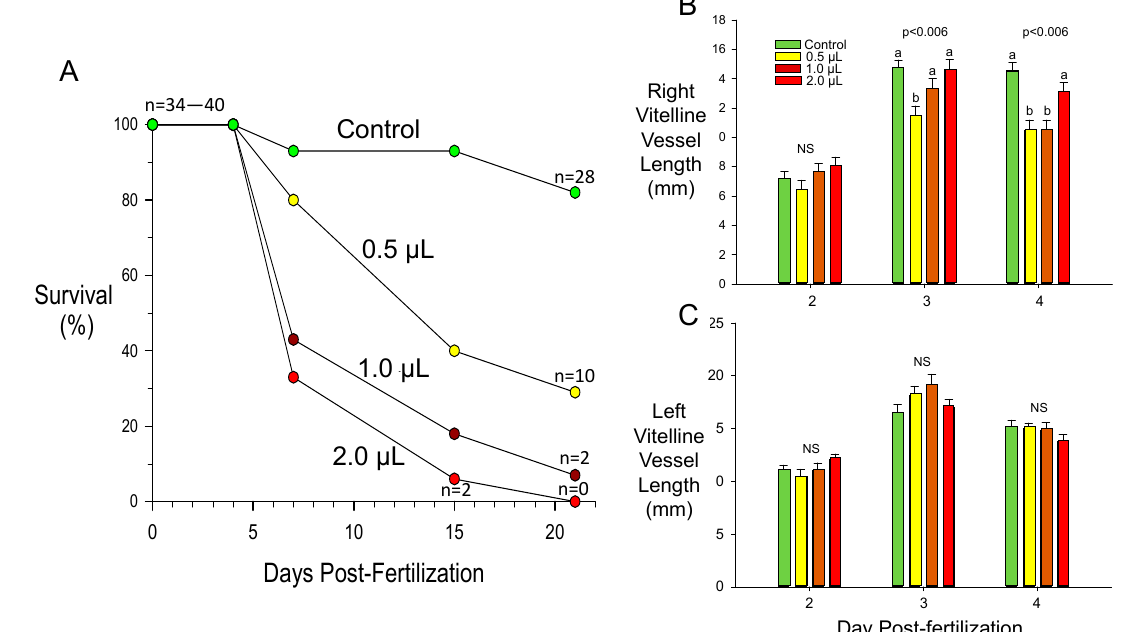
Figure 5. E ff ects of crude oil on survival and CAM vascular growth in chicken embryos grown in ovo. Doses of crude oil of 0, 0.5, 1, or 2 µ L were topically applied to the base of the umbilical artery early in Day 2 post-fertilization. ( A ) Survival curves across all embryonic development. N values of surviving embryos at the start and end of the incubation are indicated (and n at Day 15 for 2.0 µ L crude oil exposure). ( B , C ) Changes in length of specific posterior and inferior CAM vessels, respectively, as a function of crude oil dose on Days 2, 3, and 4 post-fertilization. Capital letters ( A , B ) indicate significant di ff erences between crude oil doses. NS, not significant. Note: Because the arteries and veins of the CAM vasculature typically run very closely together and in parallel to each other, it was not practical to specify a specific type of artery—hence, the general term “vessels” is used. Mean ± 1 SE are presented.